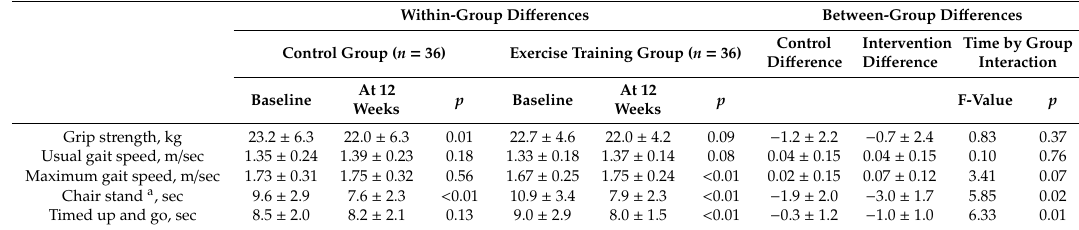
Table 2. Changes in sarcopenia-related physical function during the 12-week intervention period.